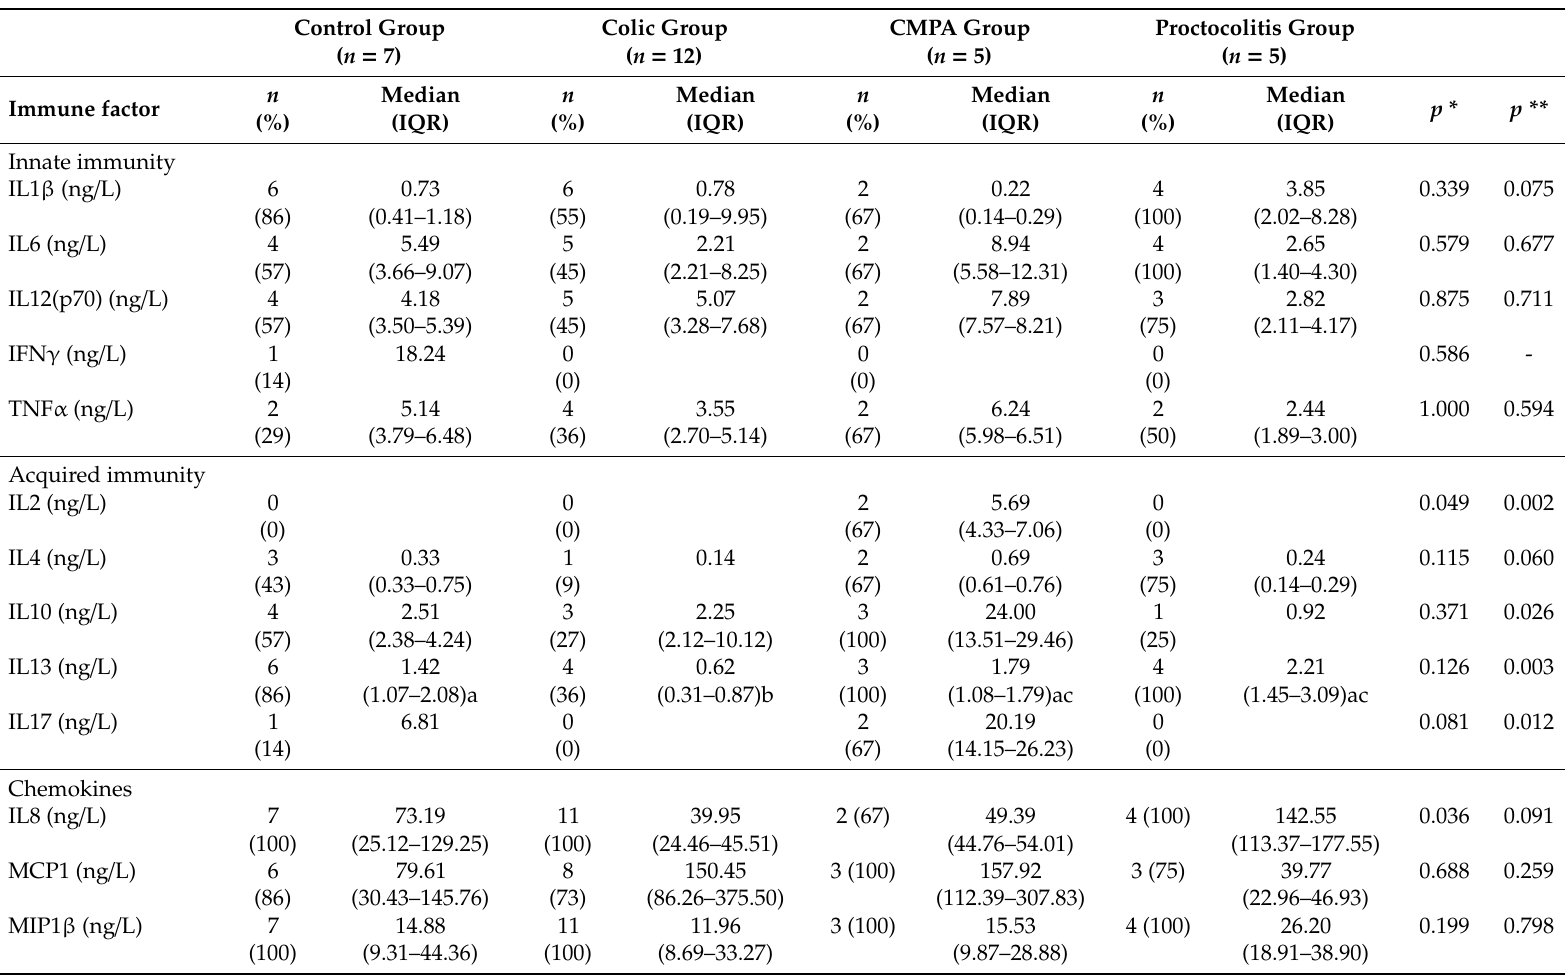
Table 5. Frequency and concentration of immune factors in milk samples ( N = 25) from participants in each group of study: control, colic, cow’s milk protein allergy (CMPA), and